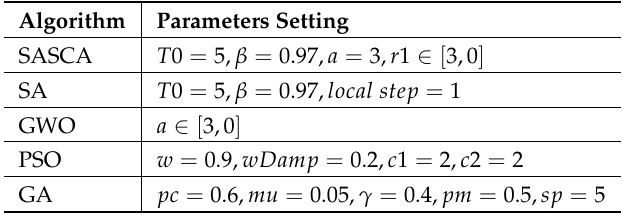
Table 13. New parameters setting for testing the sensitivity of the parameters.